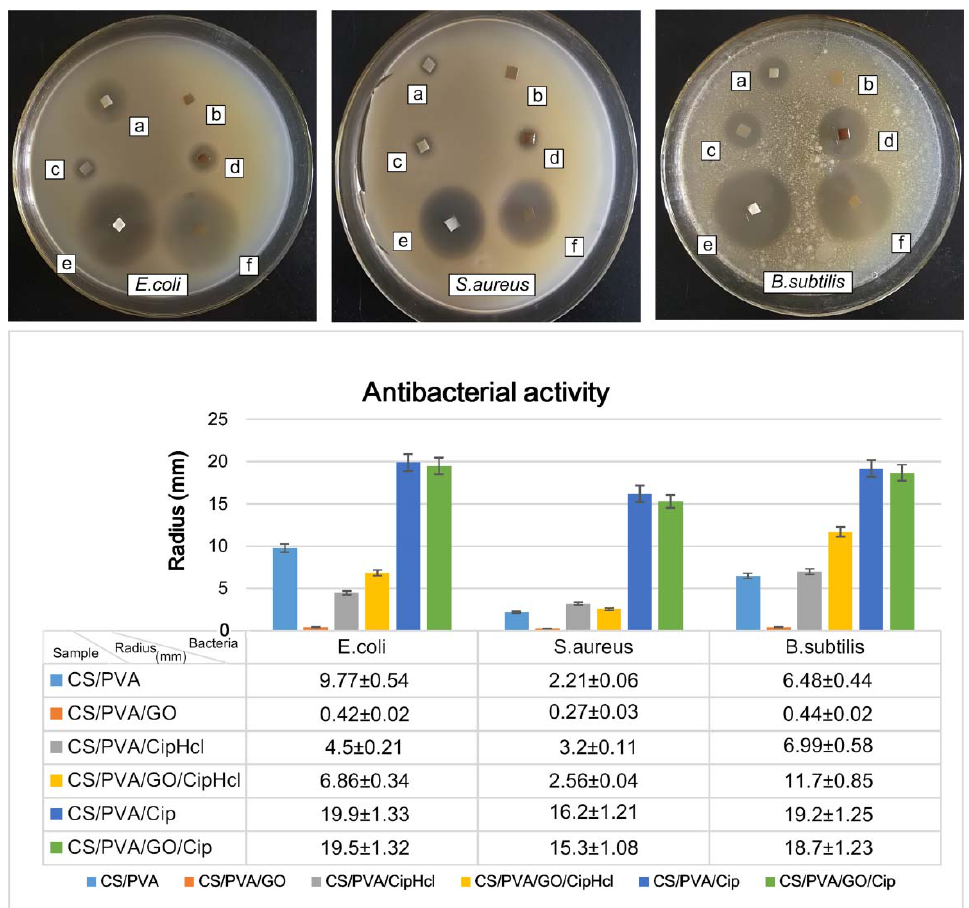
Figure 8. Photographic images and radius statistical diagram of inhibition zones of drug-loaded nanofibrous membranes: ( a ) CS / PVA nanofibrous membrane, ( b ) CS / PVA / GO nanofibrous membrane, ( c ) CS / PVA / CipHcl nanofibrous membrane, ( d ) CS / PVA / GO / CipHcl nanofibrous membrane, ( e ) CS / PVA / Cip nanofibrous membrane, ( f ) CS / PVA / GO / Cip nanofibrous membrane.